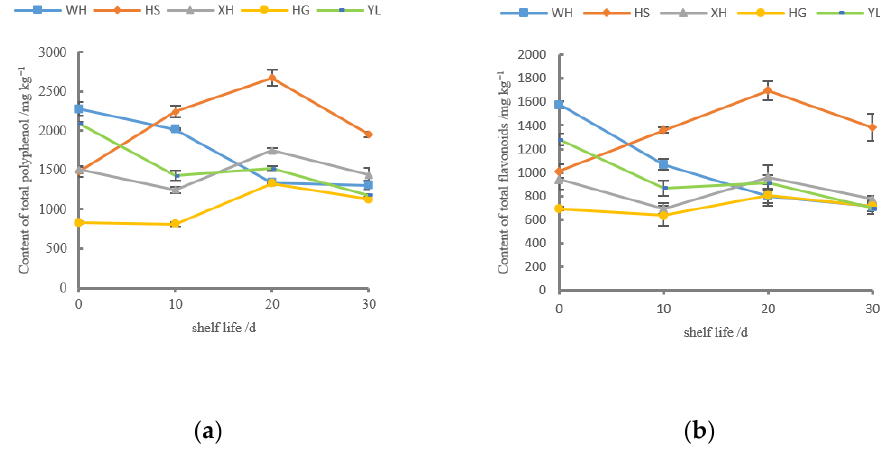
Figure 3. Changes in total polyphenol ( a ) and total flavonoids content ( b ). The trends of the variations in the total flavonoids contents of the same cultivar have a strong resemblance to the variation tendencies in the total polyphenol contents (Figure 3b). The total polyphenol content of the same cultivar was found to be much higher than total flavonoids in the same period, as expected. The variation of the total flavonoids contents in HS, XH, and HG were within the ranges 1011.20–1696.69 mg kg − 1 , 771.51–961.92 mg kg − 1 , and 634.86–807.35 mg kg − 1 , respectively, which also reached its maximum on 20 d. Statistical analyses revealed significant differences in the total polyphenol and total flavonoids contents among all tested cultivars, ( p < 0.05, Table 1); but no significant differences were found between HS and WH, XH, and YL in total polyphenol and among XH, HG and YL in total flavonoids (Table 1). Table 1. Comparative differences in the chemical composition and antioxidant activities among samples. Cultivars